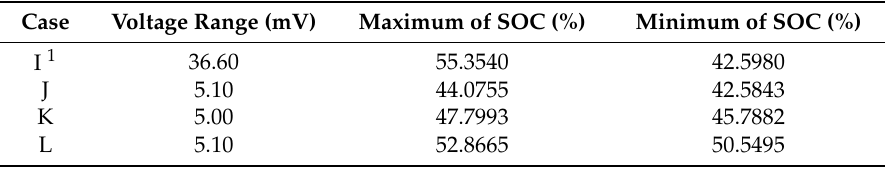
Table 6. Voltage range and SOC extremum after static